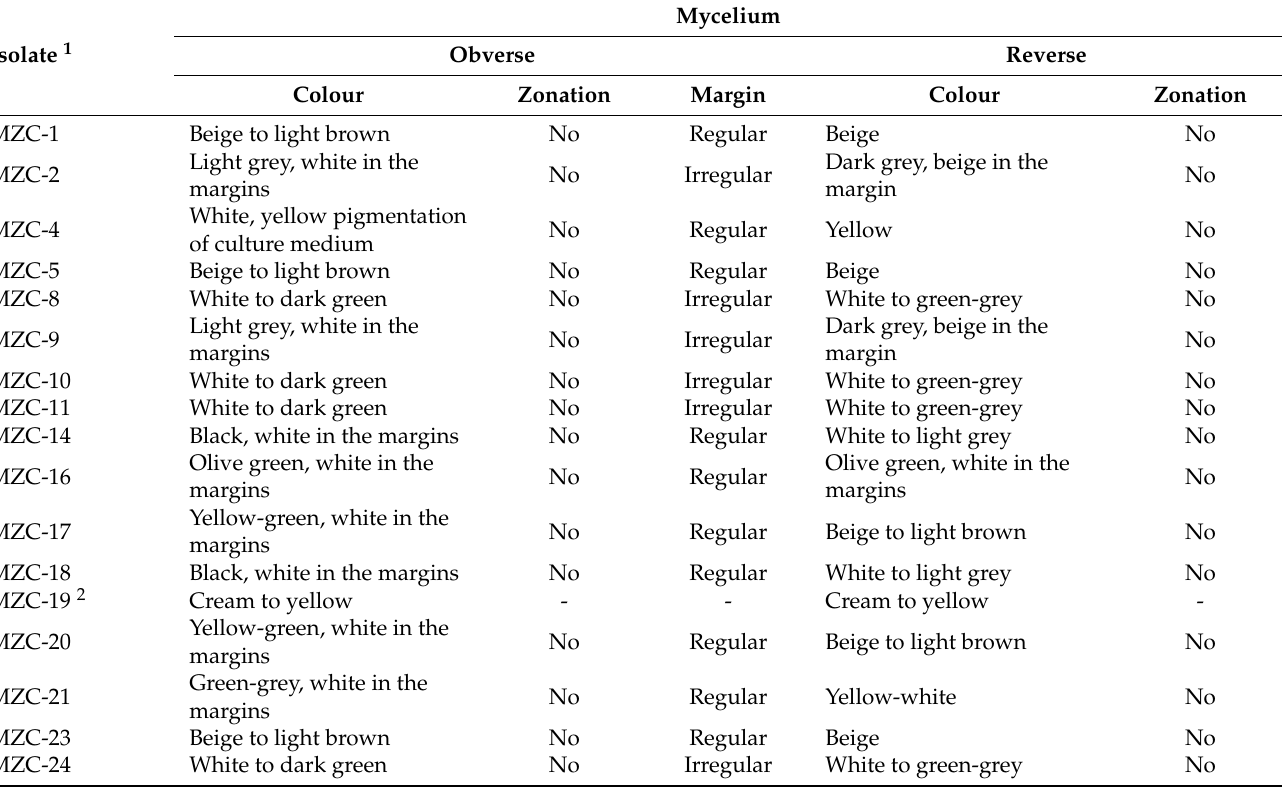
Table 3. Phenotypical characteristics of the colonies of the fungal isolates included in this study. Mycelium Isolate 1 Obverse Reverse Colour Zonation Margin Colour Zonation MZC-1 Beige to light brown No Regular Beige No Light grey, white in the Dark grey, beige in the MZC-2 No Irregular No margins margin White, yellow pigmentation MZC-4 No Regular Yellow No of culture medium MZC-5 Beige to light brown No Regular Beige No MZC-8 White to dark green No Irregular White to green-grey No Light grey, white in the Dark grey, beige in the MZC-9 No Irregular No margins margin MZC-10 White to dark green No Irregular White to green-grey No MZC-11 White to dark green No Irregular White to green-grey No MZC-14 Black, white in the margins No Regular White to light grey No Olive green, white in the Olive green, white in the MZC-16 No Regular No margins margins Yellow-green, white in the No Regular Beige to light brown No MZC-17 margins Black, white in the margins No Regular White to light grey No Cream to yellow - - Cream to yellow - Yellow-green, white in the No Regular Beige to light brown No MZC-20 margins Green-grey, white in the MZC-21 No Regular Yellow-white No margins MZC-23 Beige to light brown No Regular Beige No MZC-24 White to dark green No Irregular White to green-grey